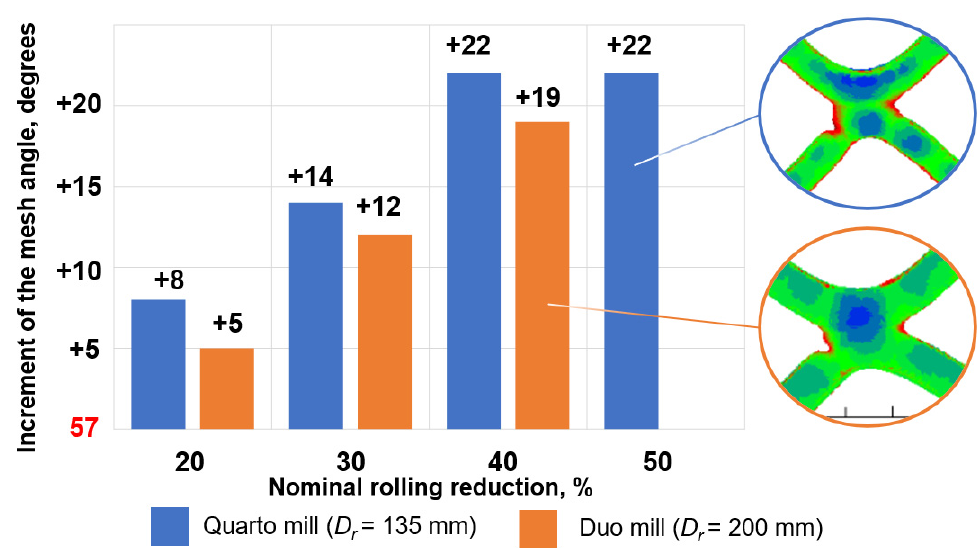
Figure 4. Visualization of the increment of the inlay mesh angle after roll bonding with various reductions using two types of rolling mills: the rolling mill with a roll diameter ( D r ) of 200 mm is called “duo”, the mill with ( D r ) of 135 mm “quarto”. The left part shows the hotspots of the localized deformation near mesh knuckles.